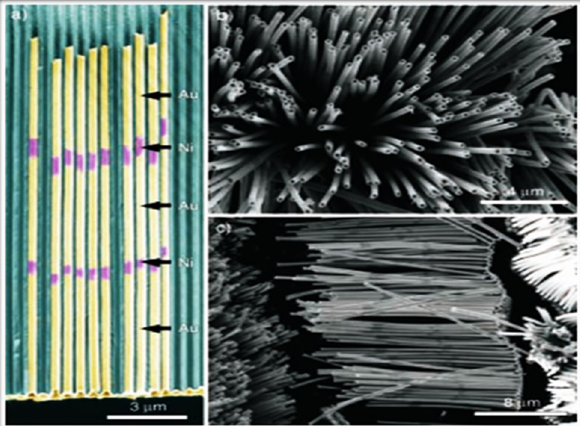
Figure 10: The images of multisegmented nickel nanotubes using SEM Lee et al . [ 112 ]